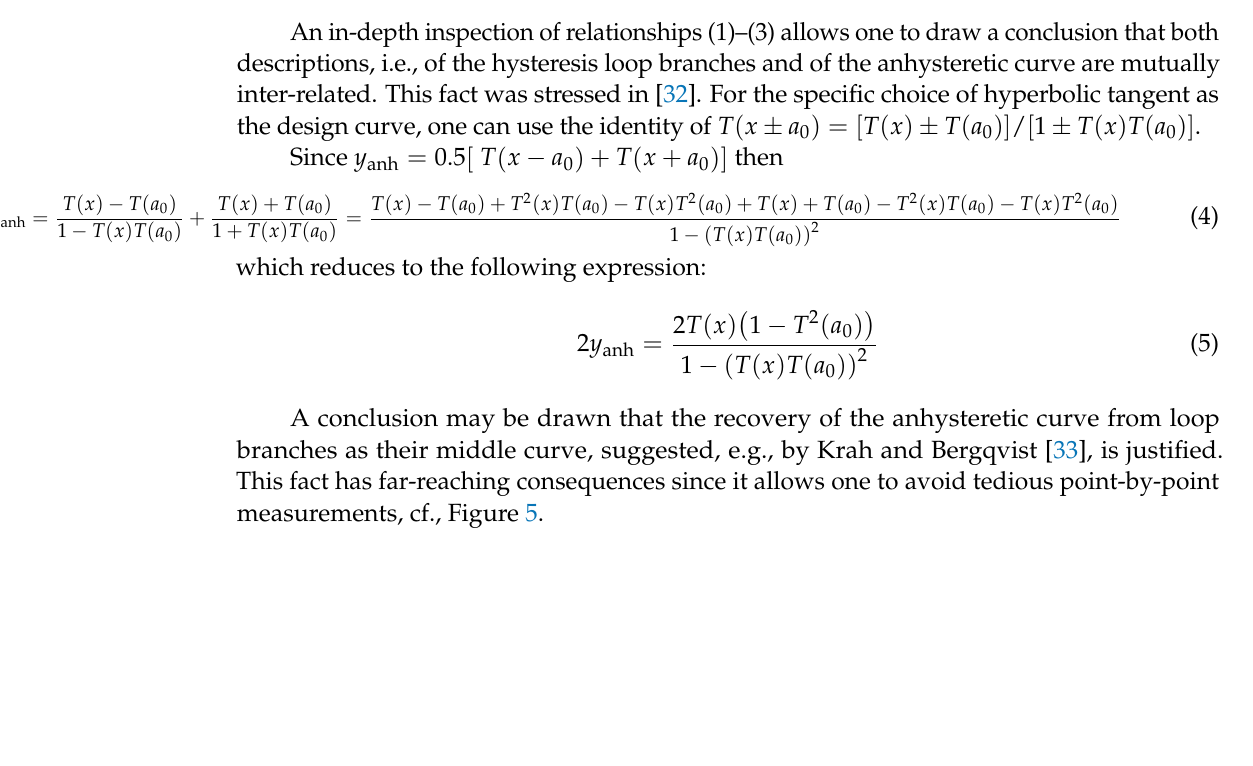
Figure 4. Simulated major hysteresis loops (dashed line) and anhysteretic curves (solid lines) for two values of the reduced coercive field ( a 0 = 1, 2 using Takács’ notation) and 𝑥 m = 4.